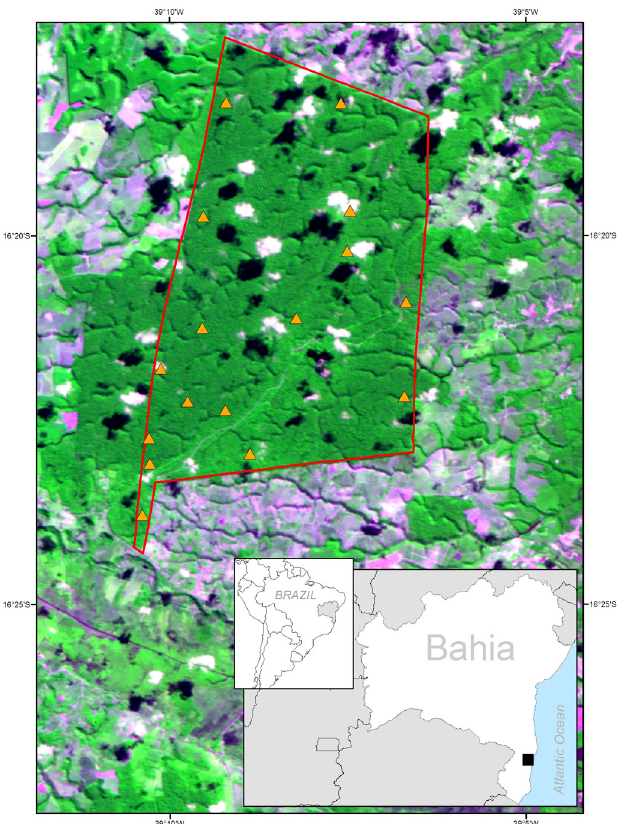
Figure 1. Location of RPPN Estação Veracel, state of Bahia, northeastern Brazil. Triangles indicate the location of camera